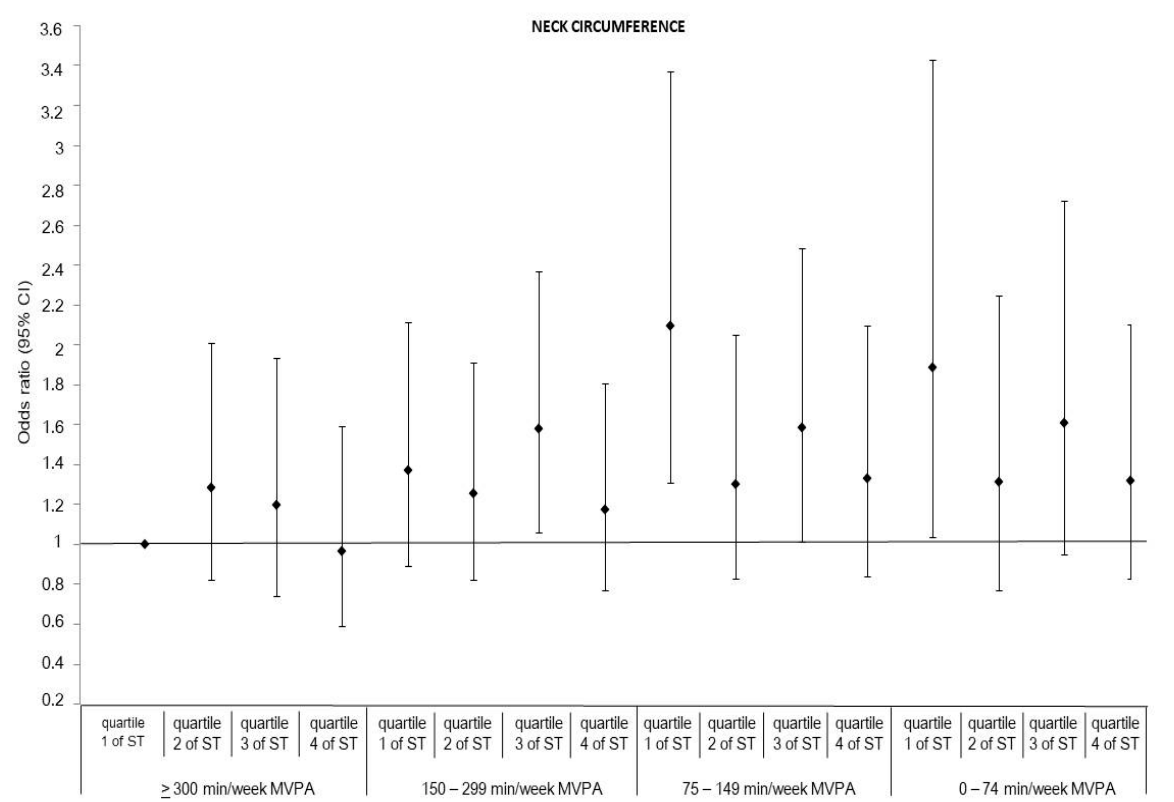
Figure 4. Joint associations of sedentary time and moderate-to-vigorous physical activity with obesity by neck circumference. The analyses were adjusted for country, sex, age, marital status, socioeconomic status, and race/ethnicity.